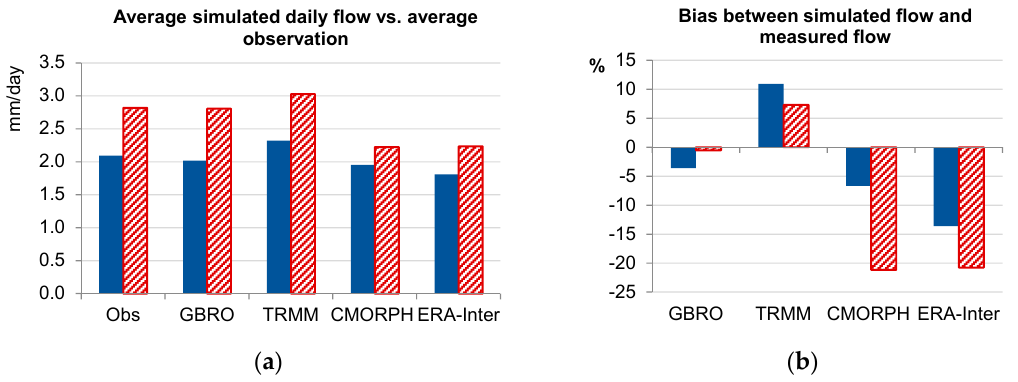
Figure 8. ( a ) Average simulated vs. average observation daily flow and ( b ) Bias between simulated flow from different rainfall sources and measured flow (blue: calibration period, red pattern: validation period). Table 5. Statistical criteria of different simulations at daily scale.